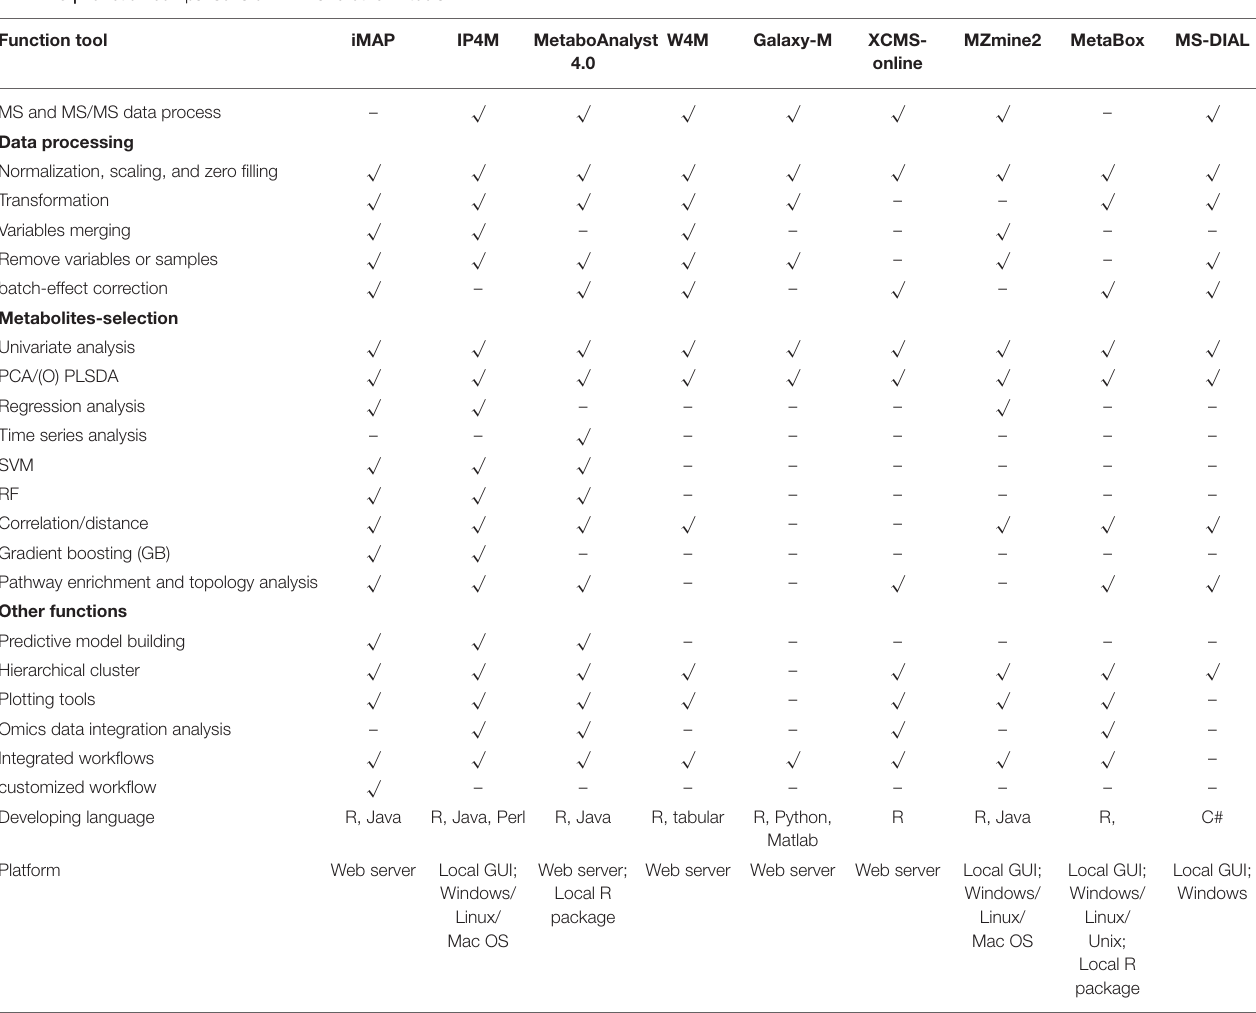
TABLE 3 | Function comparisons of iMAP and other 7